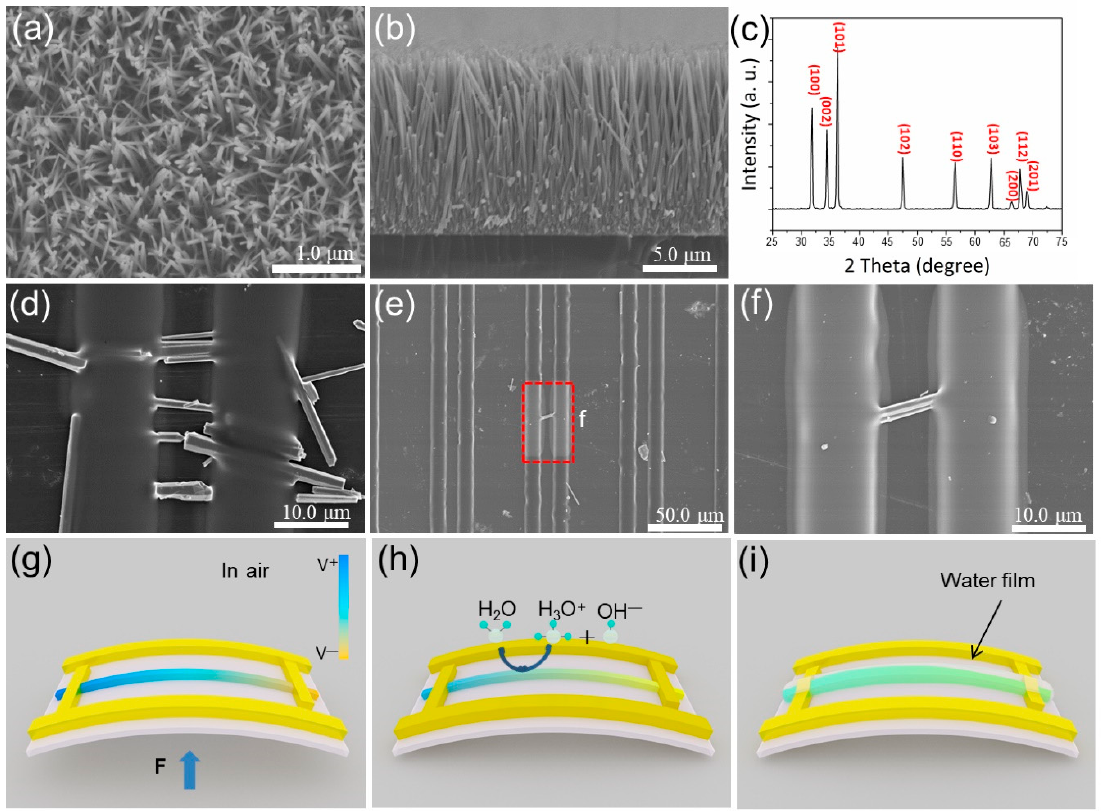
Figure 2. ( a ) Top view SEM image of ZnO. ( b ) Side view SEM image of ZnO. ( c ) XRD image of ZnO. ( d ) SEM image of ZnO NWs crossing a pair of electrodes in the same direction. ( e ) SEM image of a single ZnO NW crossing a pair of electrodes. ( f ) High-magnification morphology of a single ZnO NW crossing a pair of electrodes (Figure 2e). ( g ) Working mechanism of ZnO NW. ( h ) Working mechanism of ZnO NW under low-humidity conditions. ( i ) Working mechanism of ZnO NW under high-humidity conditions.